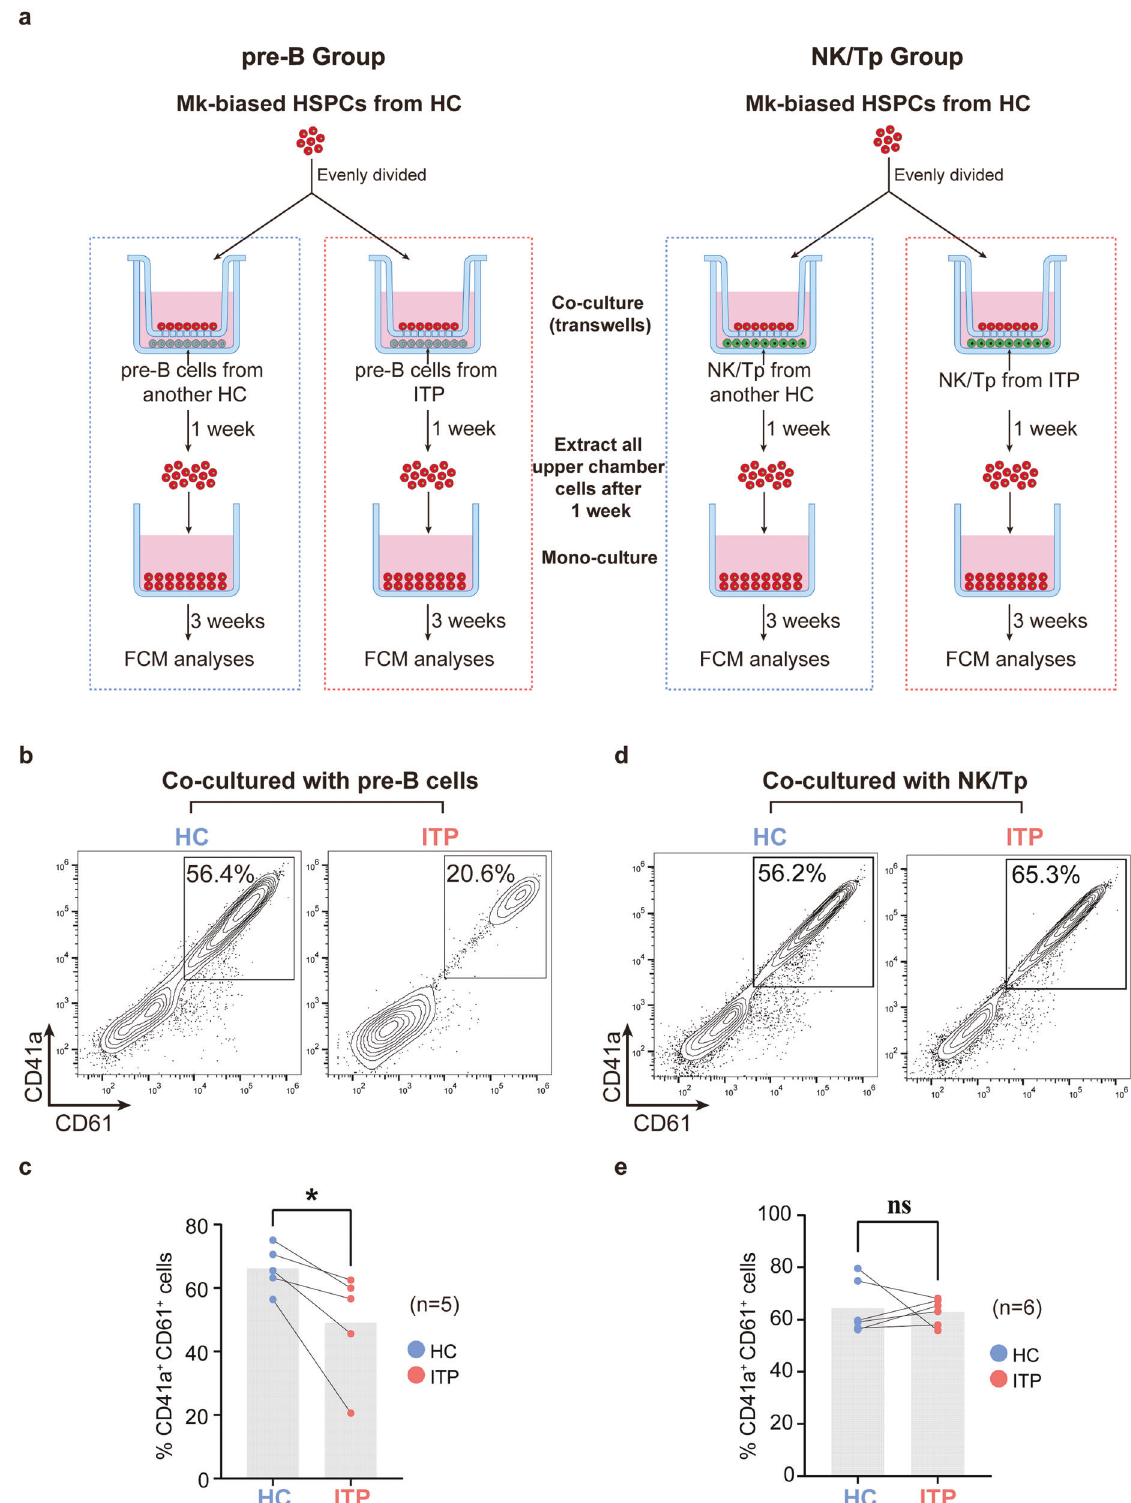
Fig. 6 Co-culture of immune cell progenitors and Mk-biased HSPCs. a Experimental strategy. Schematic illustration of the transwell co-culture systems. Related to Fig. 6. b , c The proportion of CD41a + CD61 + cells derived from CD9 + Lin − CD34 + CD45RA − HSPCs co-cultured with pre-B cells of HC and ITP, respectively. Two-tailed Student ’ s t test; * p < 0.05; n = 5. d , e The proportion of CD41a + CD61 + cells derived from CD9 + Lin − CD34 + CD45RA − HSPCs co-cultured with NK/Tp cells of HC and ITP, respectively. Two-tailed Student ’ s t test; ns, not signi fi cant; n =